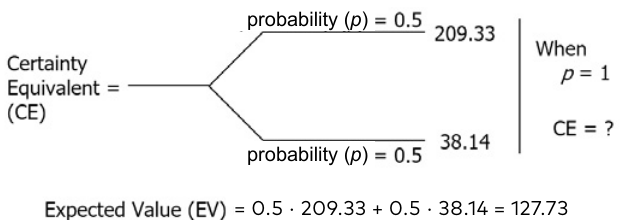
Figure 2. Lottery question to discern Maintenance Costs